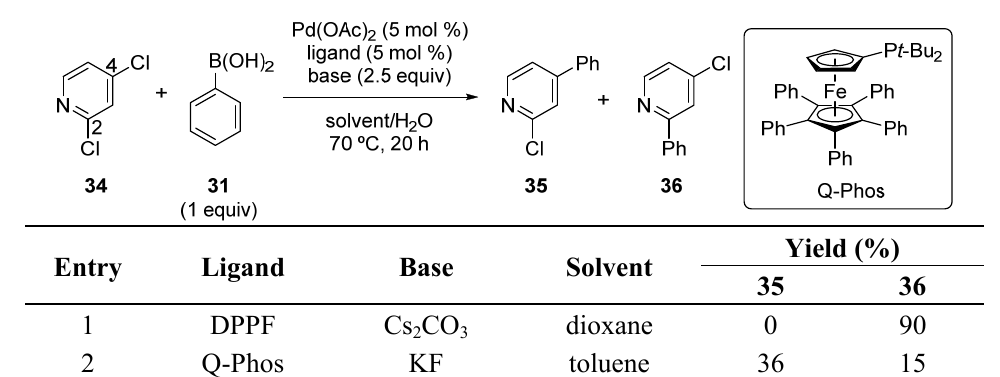
4. Site-selective Suzuki ‒ Miyaura coupling of